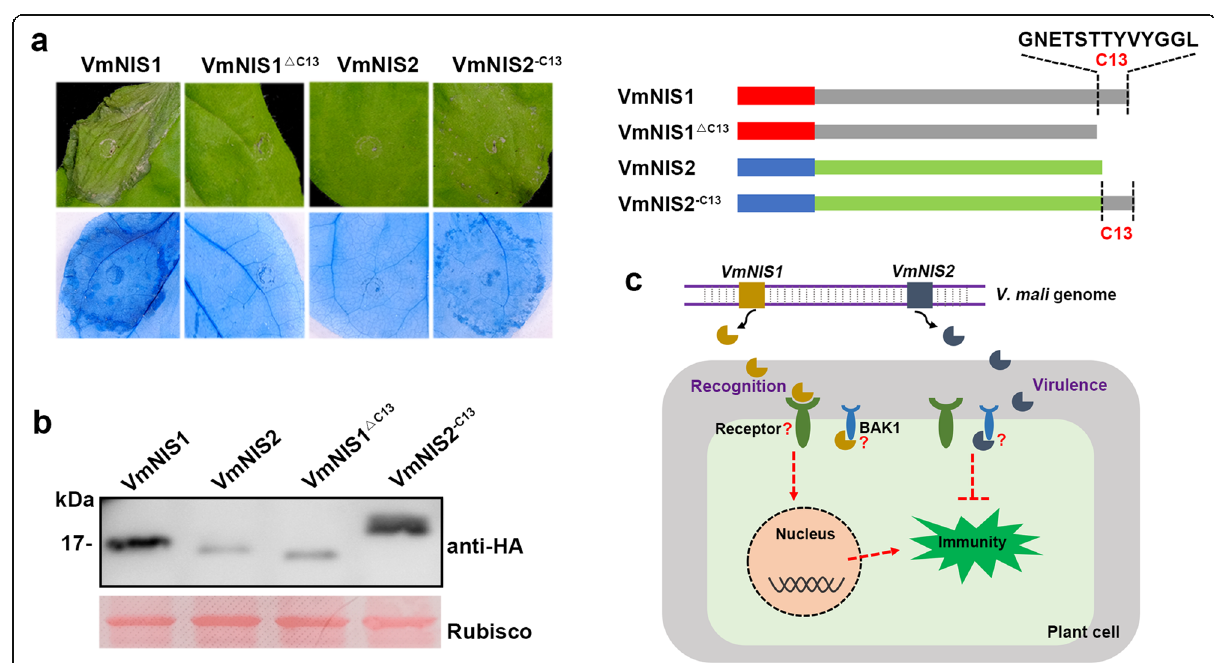
Fig. 7 VmNIS2 may escape plant detection by C-terminal truncation. a. Representative leaves showing cell death induced by VmNIS1 and VmNIS2 -C13 in N. benthamiana . VmNIS1, VmNIS1 Δ C13 , VmNIS2 and VmNIS2 -C13 were transiently expressed in N. benthamiana by agroinfiltration. Photographs were taken 5 dpa. Cell death symptom was further visualized by trypan blue staining. A diagram showing the protein constructs is depicted. b. Western blotting detection of the expressed proteins with anti-HA antibody. Ponceau S-stained Rubisco protein was shown as a loading control. c. A proposed model for VmNIS1 and VmNIS2 function in plant-pathogen interactions. VmNIS1 is recognized by the plant via a yet-unknown receptor and activates plant immunity. VmNIS2 serves as a virulence factor that escapes plant recognition and suppresses plant